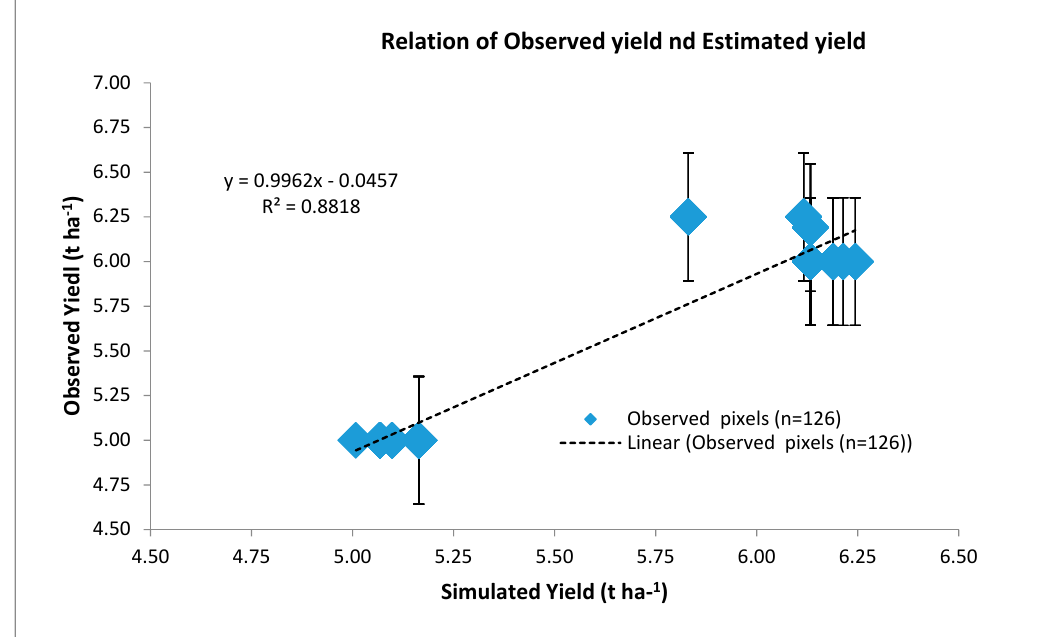
Figure 8. The relationship between simulation yield and observed yield; error bar represents the standard deviation of field measurement (Average of each group).